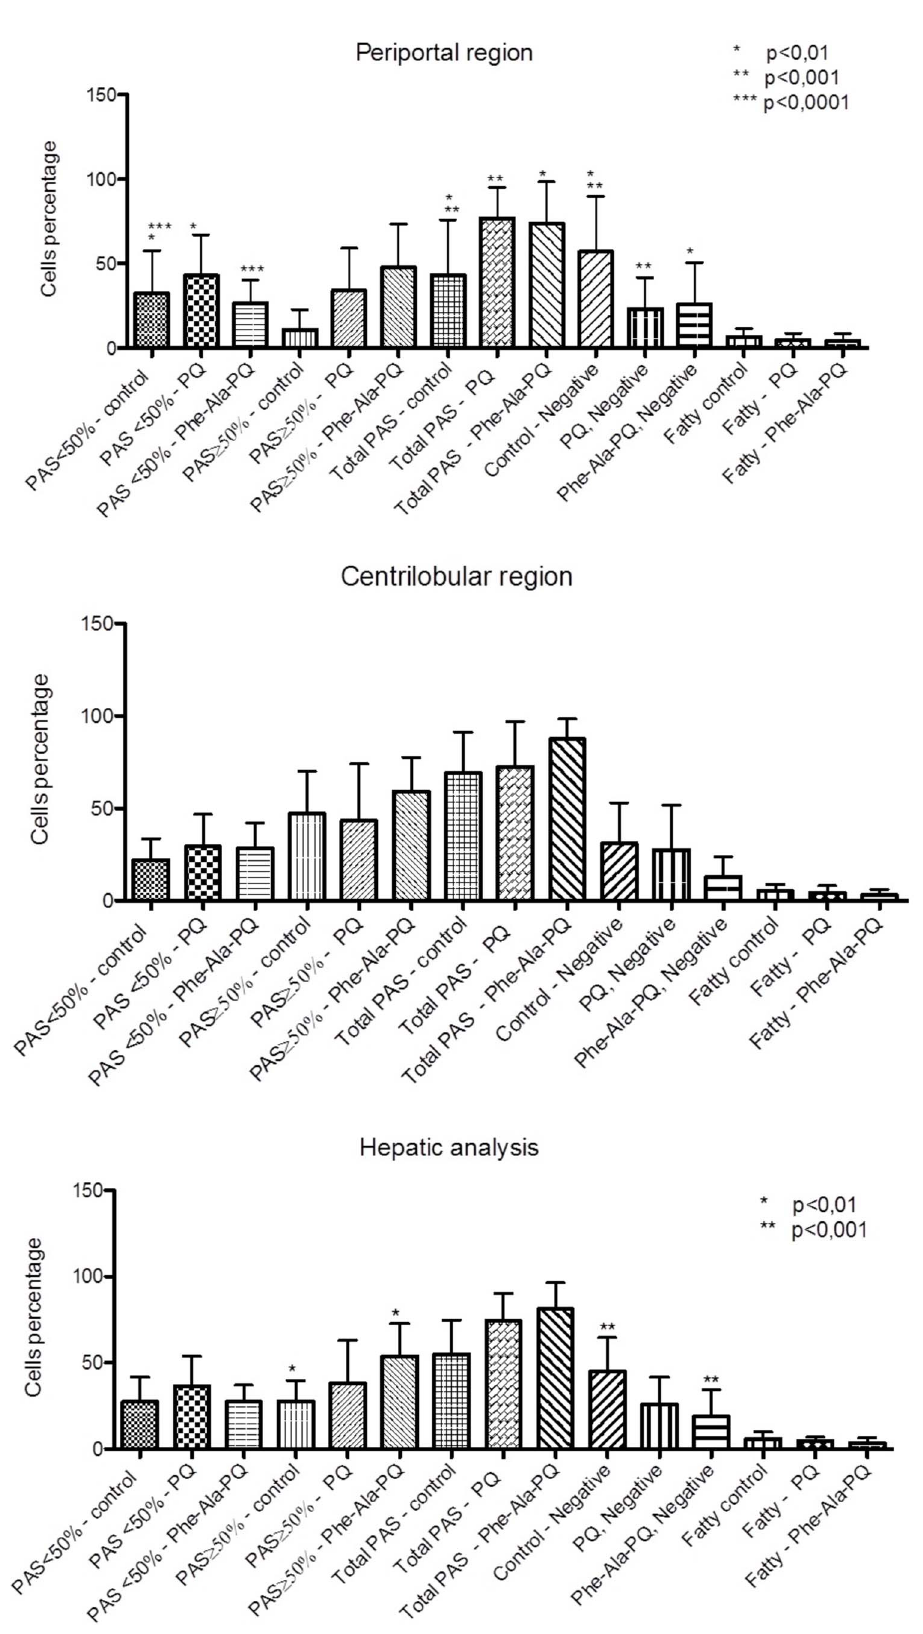
Figure 2. Hepatic analysis of glycogen: periportal region, centrilobular region and hepatic analysis (periportal + centrilobular regions). doi:10.1371/journal.pone.0105217.g002 PLOS ONE |